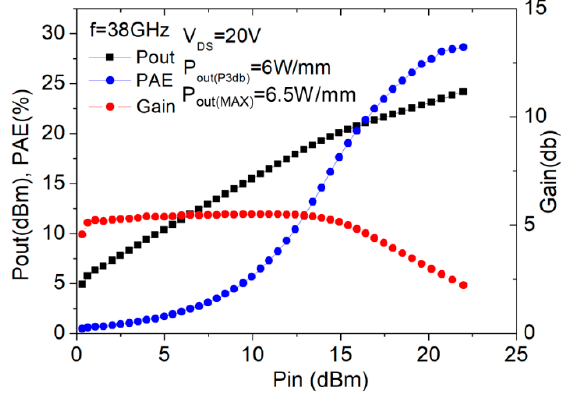
Figure 11. Large-signal performance of the 2 × 20 μ m device with copper metallization.